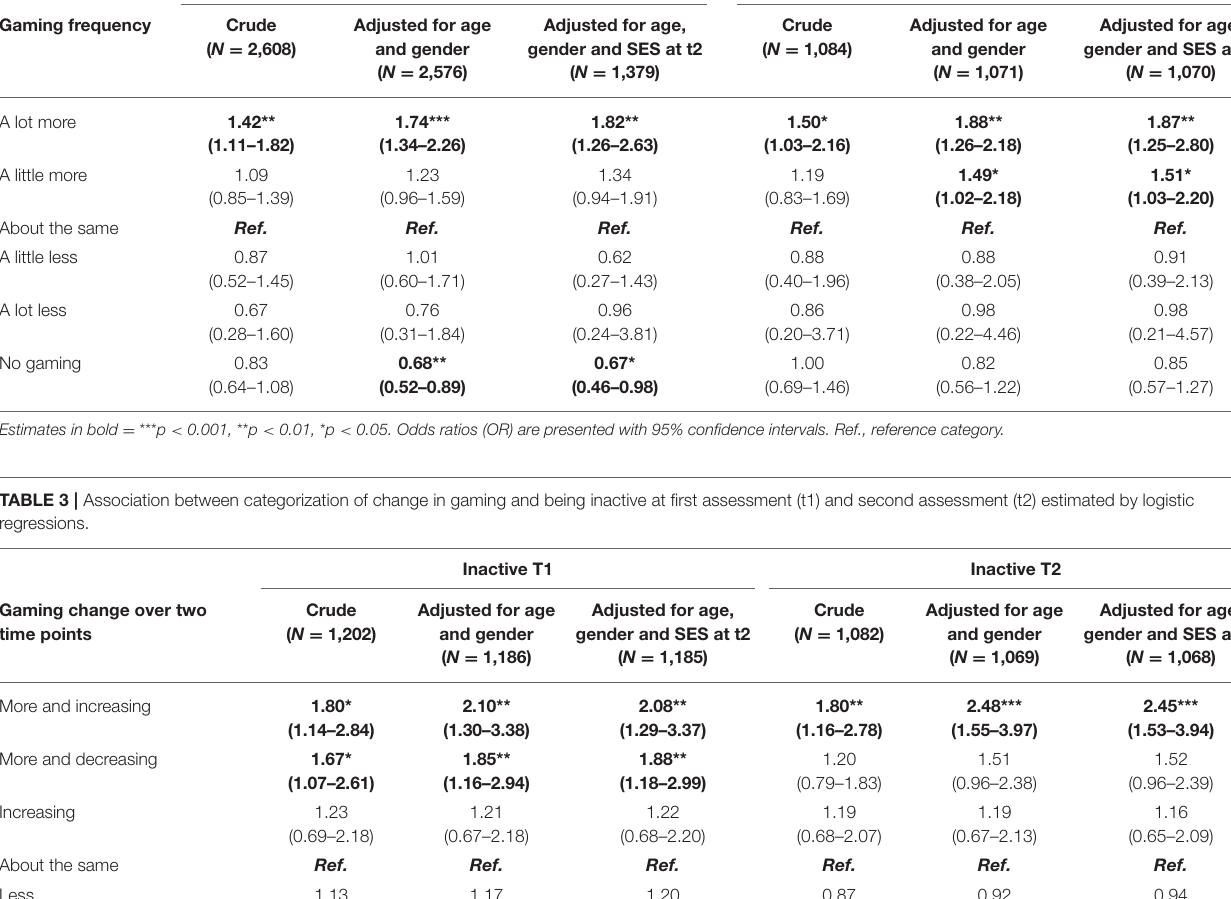
TABLE 2 | Associations between reported change in gaming and being physical inactive at first assessment (t1) and second assessment (t2) estimated by logistic regressions.